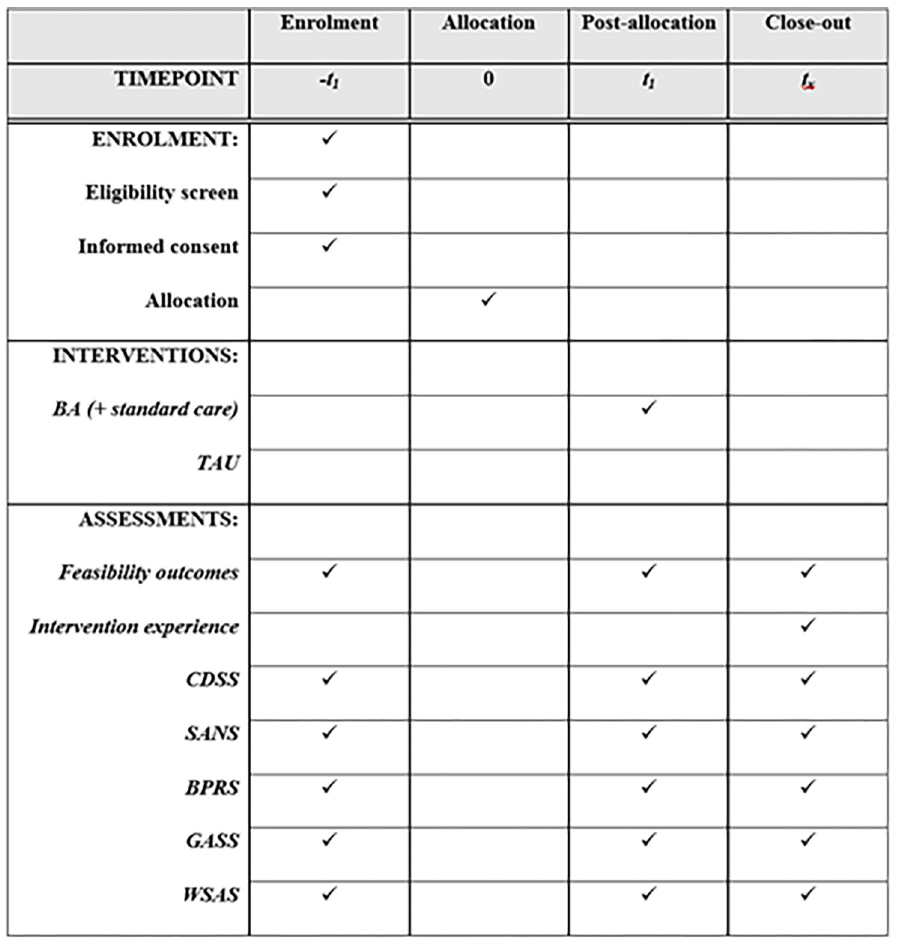
Fig 1. Schedule of enrolment, interventions, and